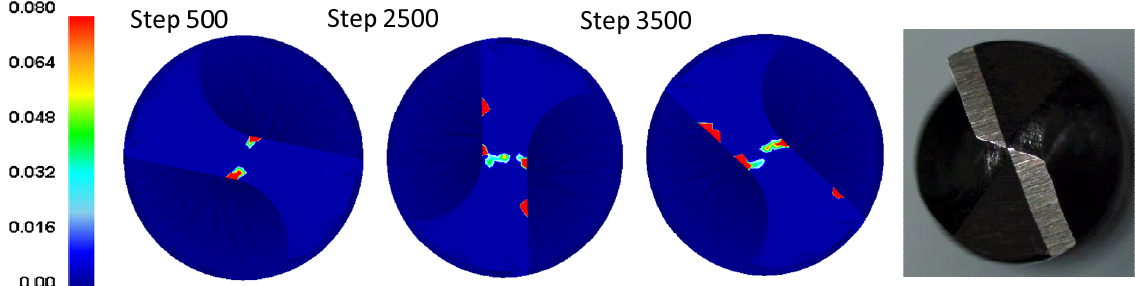
Figure 15. Simulated and experimental drill wear.